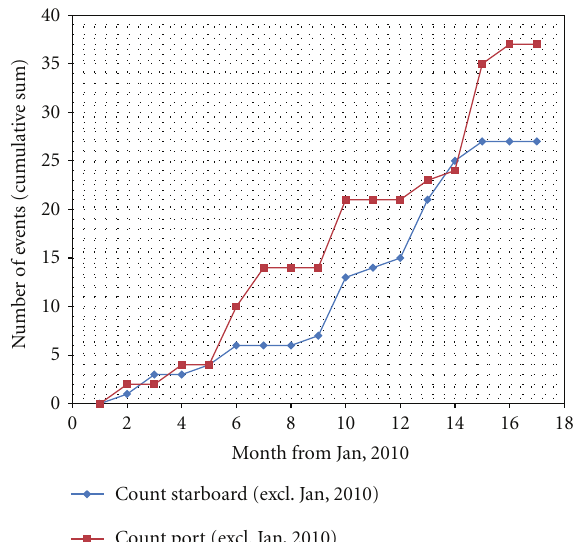
Figure 28: Cumulative sum of events for the starboard and the port unit.